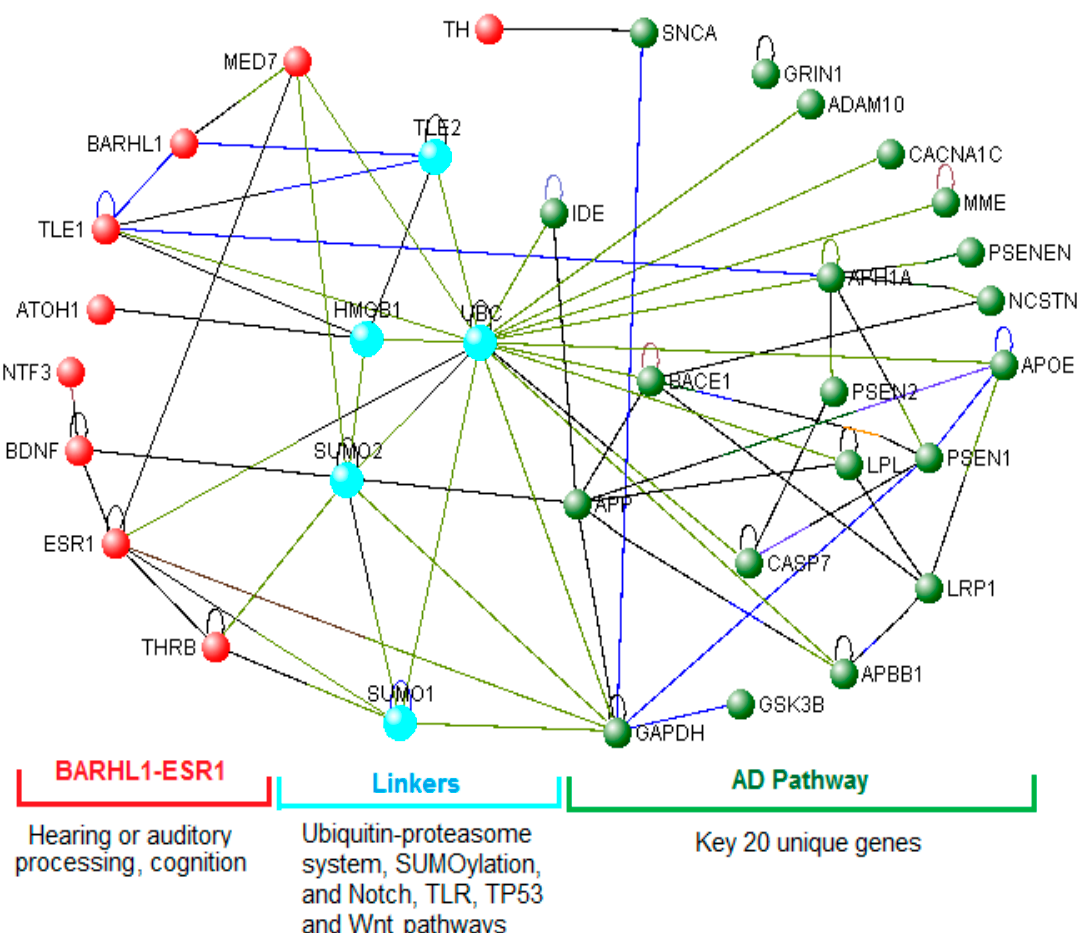
Figure 5. Key linkers (UBC, SUMO1, SUMO2, HMGB1 and TLE2) between the BARHL1-ESR1 axis and the Alzheimer’s Disease (AD) pathway.